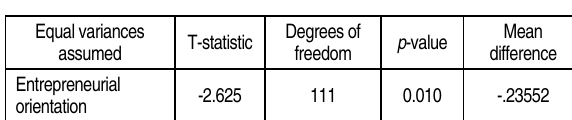
Table 7. Hypothesis testing three –